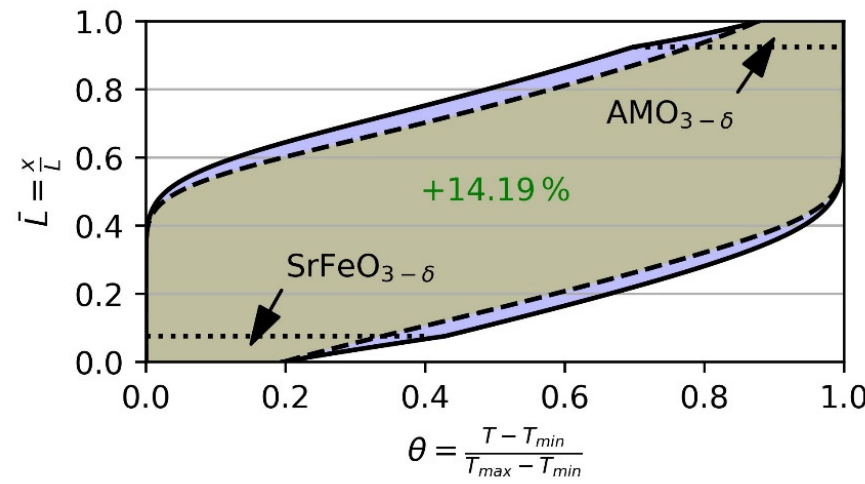
Figure 12. Possible thermocline behavior of a cascaded storage with 7.5% volume replacement by SrFeO 3 − δ at the bottom and a hypothetical AMO 3 − δ perovskite at the top of the storage. In the remaining 85% in the center of the TES bauxite was considered. Thus, storage capacity is increased by 14.19% (local increase indicated by purple area) compared to the base case V0 (dashed black lines) using non-reactive particles only.